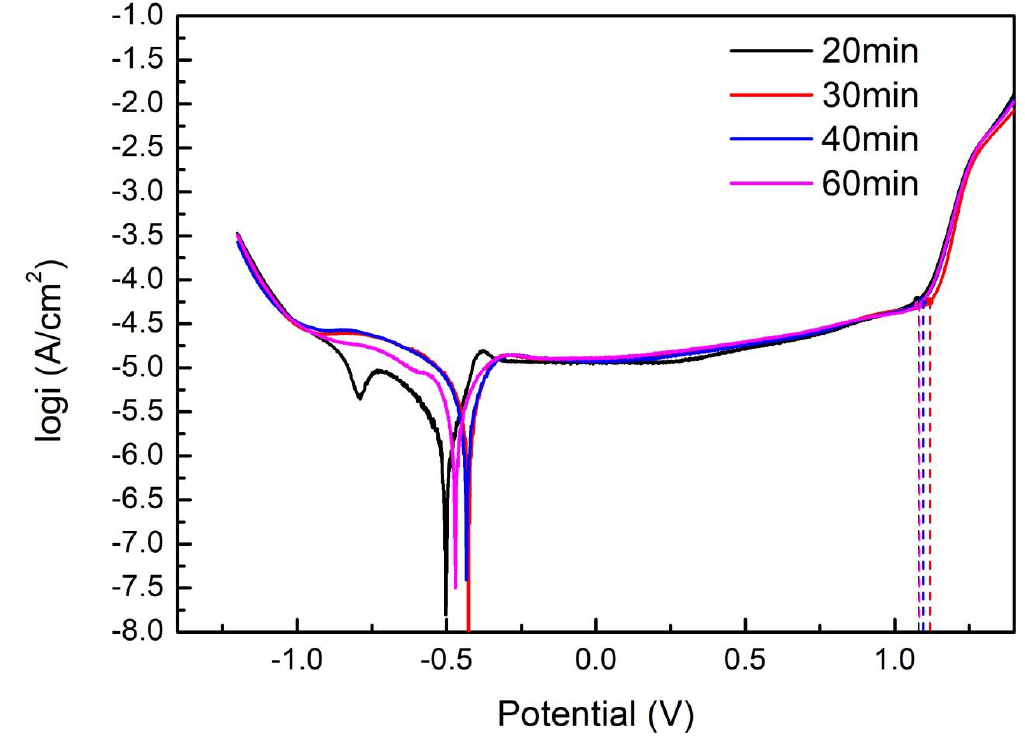
Crystals 2020 , 10 , x FOR PEER REVIEW 11 of 16 Figure 10. Polarization curves of S32750 stainless steel with different annealing times. Figure 10. Polarization curves of S32750 stainless steel with di ff erent annealing times.